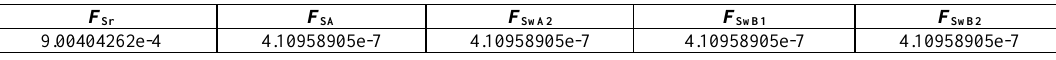
(𝑡 = 8640h), 𝑖 ∈ {Sr, SA, SwA2, SwB1, 𝑖